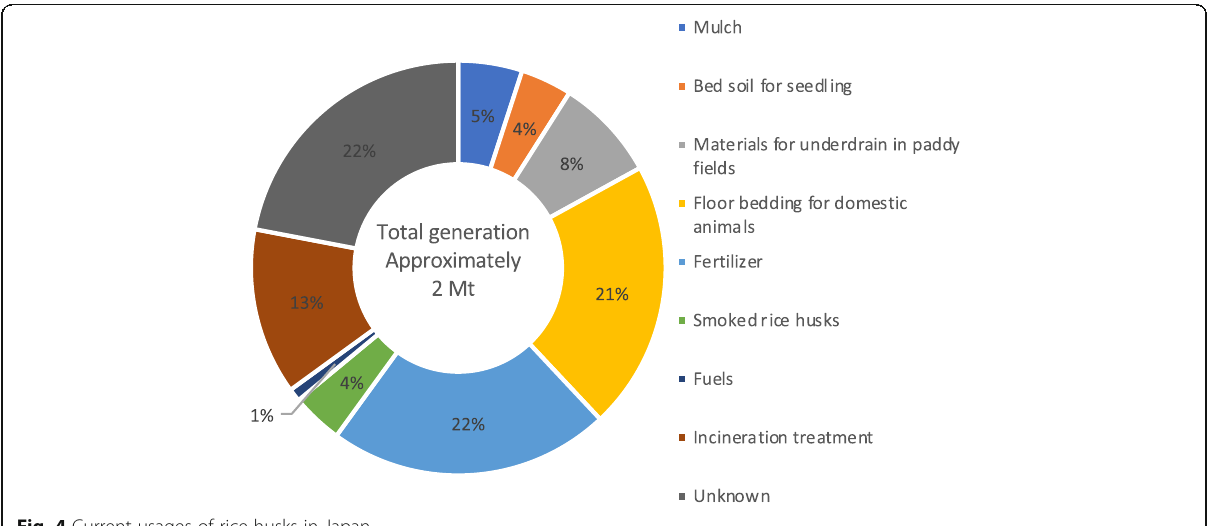
Fig. 4 Current usages of rice husks in